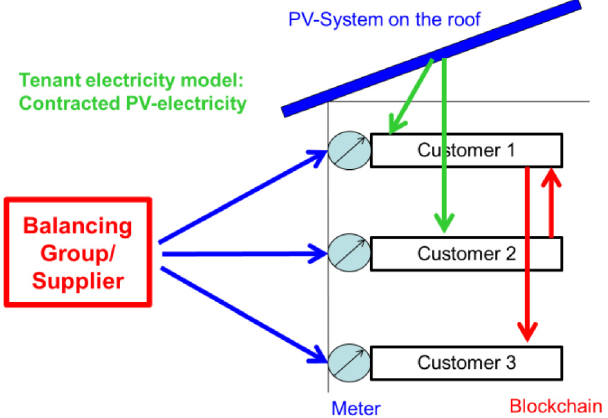
Fig. 10. Data management tools to coordinate transactions for distributed electricity customers in an